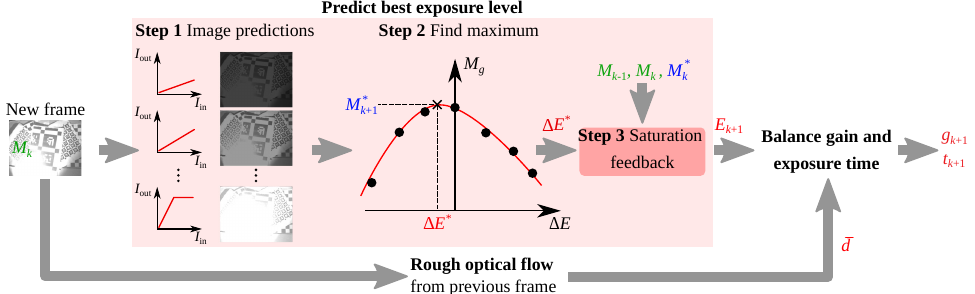
Figure 2. Schematic of the AE algorithm proposed in the present